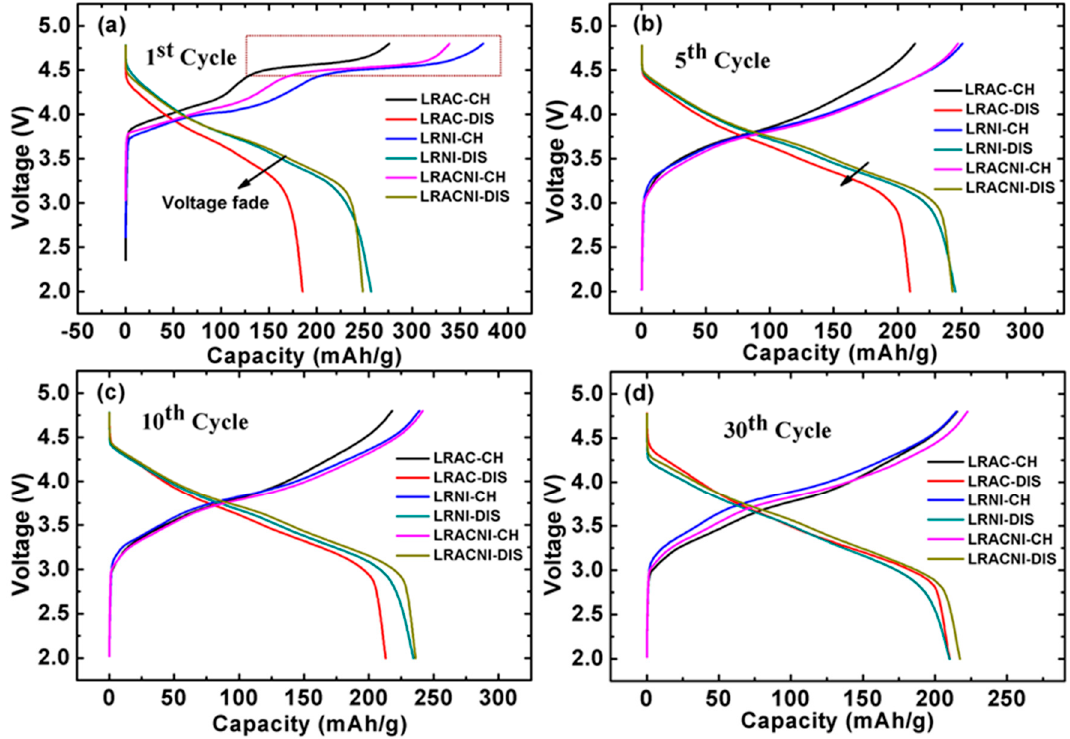
Figure 6. ( a ) 1st; ( b ) 5th; ( c ) 10th; and ( d ) 30th charge/discharge curves for LRAC, LRNI, and